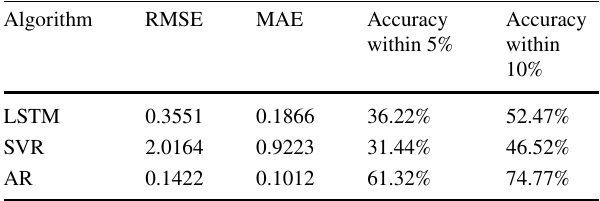
Table 1 Prediction effects of the different algorithms